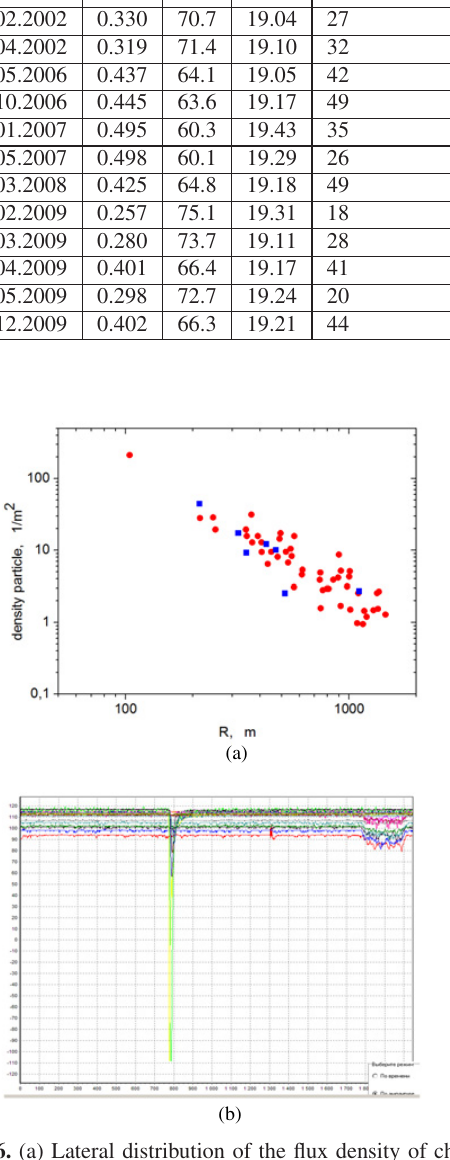
Figure 6. (a) Lateral distribution of the flux density of charged particles (red dots) and muons with ε thr ≥ 2GeV (blue dots) in the shower with E 0 = 1 . 5 · 10 19 eV and zenith angle θ = 64 . 8 ◦ . (b) Air shower signal scan, registered on 10.03.2008 by scintillation detectors (colored in darker colors) and Cherenkov light detectors (brighter colors).